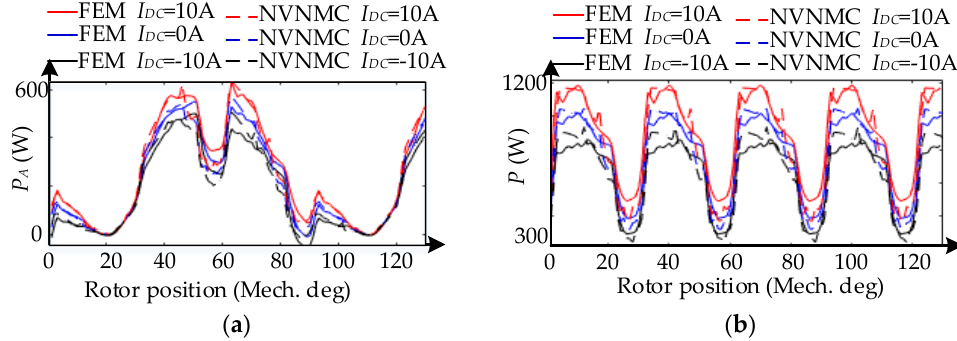
Figure 12. Input power with different DC current: ( a ) Power of phase A; ( b ) Total input power.